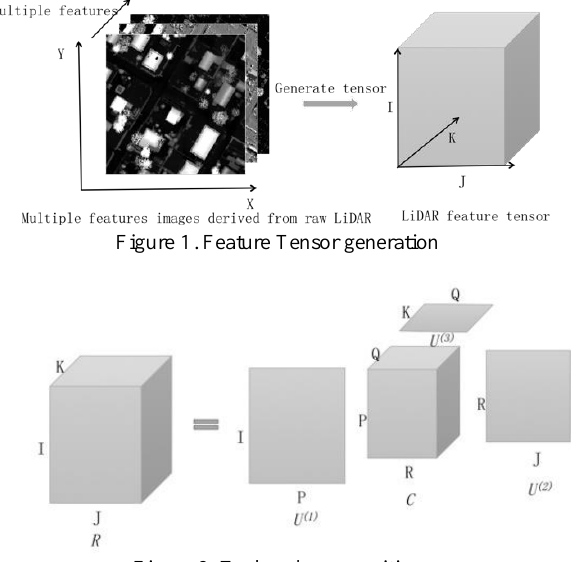
Figure 2. Tucker